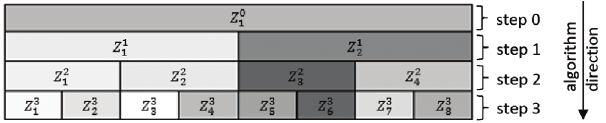
Fig. 1. The gray level of the individual cell back- ground corresponds to value assigned to the cell in exemplary realization.